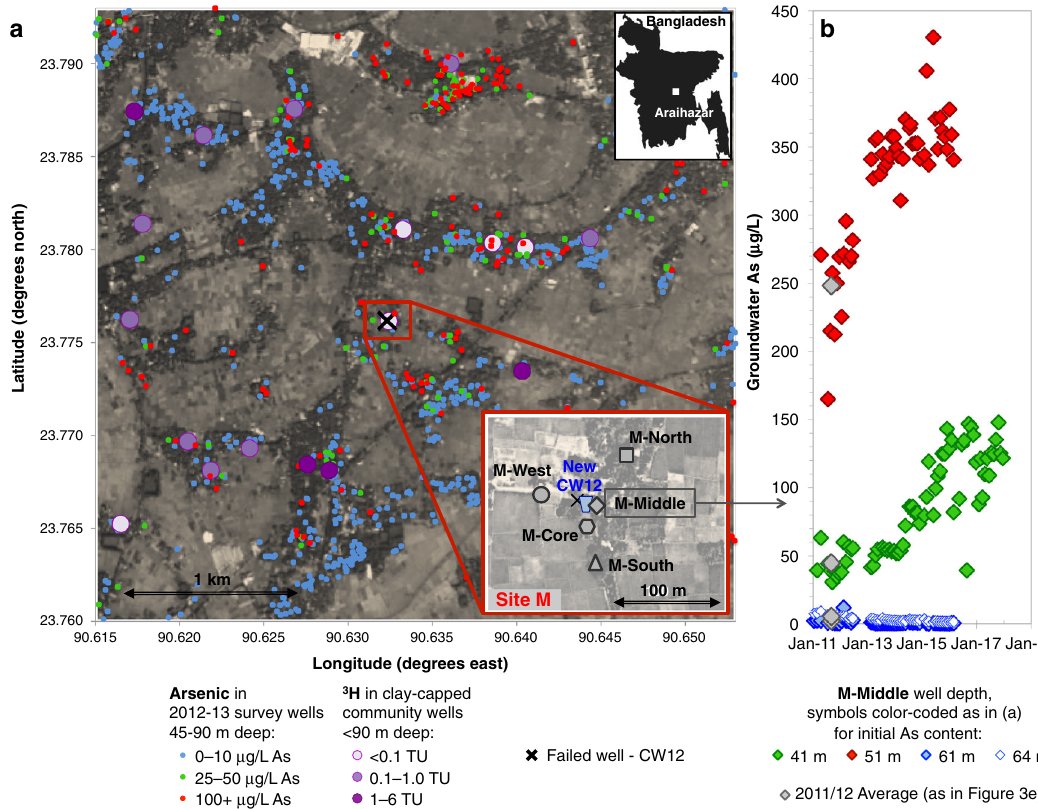
Fig. 1 Regional and site map with tritium ( 3 H) and arsenic (As) distribution. a Map of the fi eld area and the focus site M. The small symbols denote the wells 45 – 90 m deep, surveyed in 2012 – 13 and color corded according to their As concentration measured using the ITS Arsenic Econo-Quick kit 37,70 . The large symbols denote the surrounding (2 km radius) community wells installed <90 m deep within a clay-capped low-As aquifer 36 and are color coded to re fl ect the highest measured 3 H concentrations in tritium units (TU), as reported in Mihajlov et al. 48 . The enlarged inset map of site M displays sampled multi-level well nest locations, an additional coring location, and the location of community well (CW12) where arsenic concentrations rose twice prior to reinstallation at a greater depth. b Time-series of As concentrations in groundwater at the well cluster M-Middle from 2011 to 2017 (41 m) or from 2011 to 2016 (other depths); 2011/2012 average As concentrations plotted on Fig. 3e are also shown.